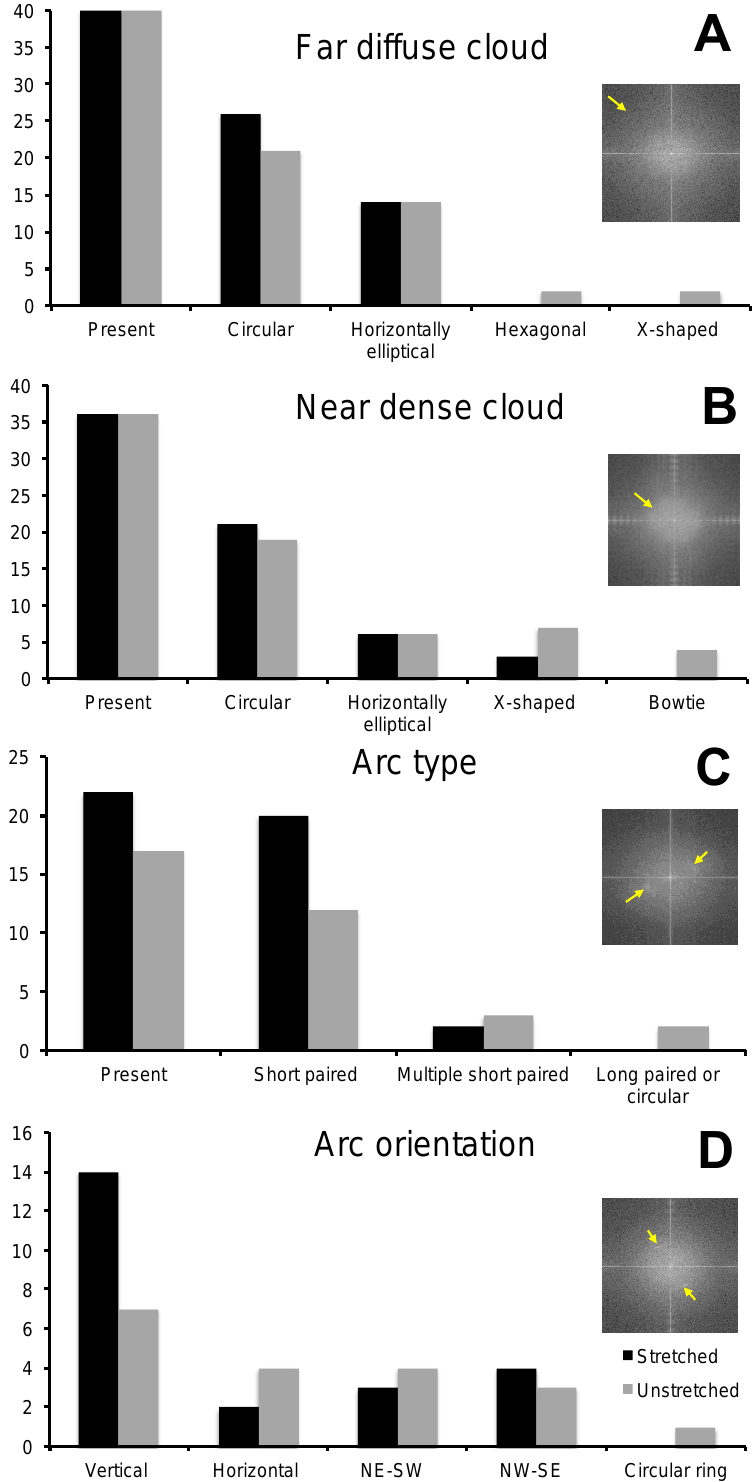
Figure 6. Characterization of qualitative features from fast Fourier transform analysis of phase images of stretched and unstretched silk threads from Arachnocampa tasmaniensis glowworms. Arrows within inset panels are used to demonstrate the edge of the far diffuse cloud ( A ) and near dense cloud ( B ), arc presence ( C ) and orientation ( D ).